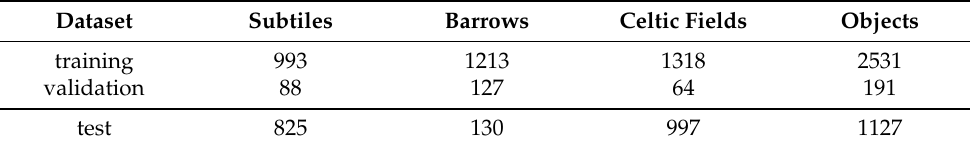
Table 2. The datasets used in this